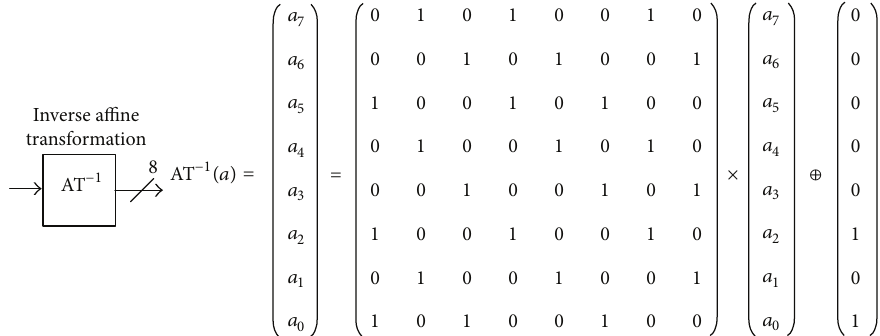
Figure 12: The matrix for inverse affine